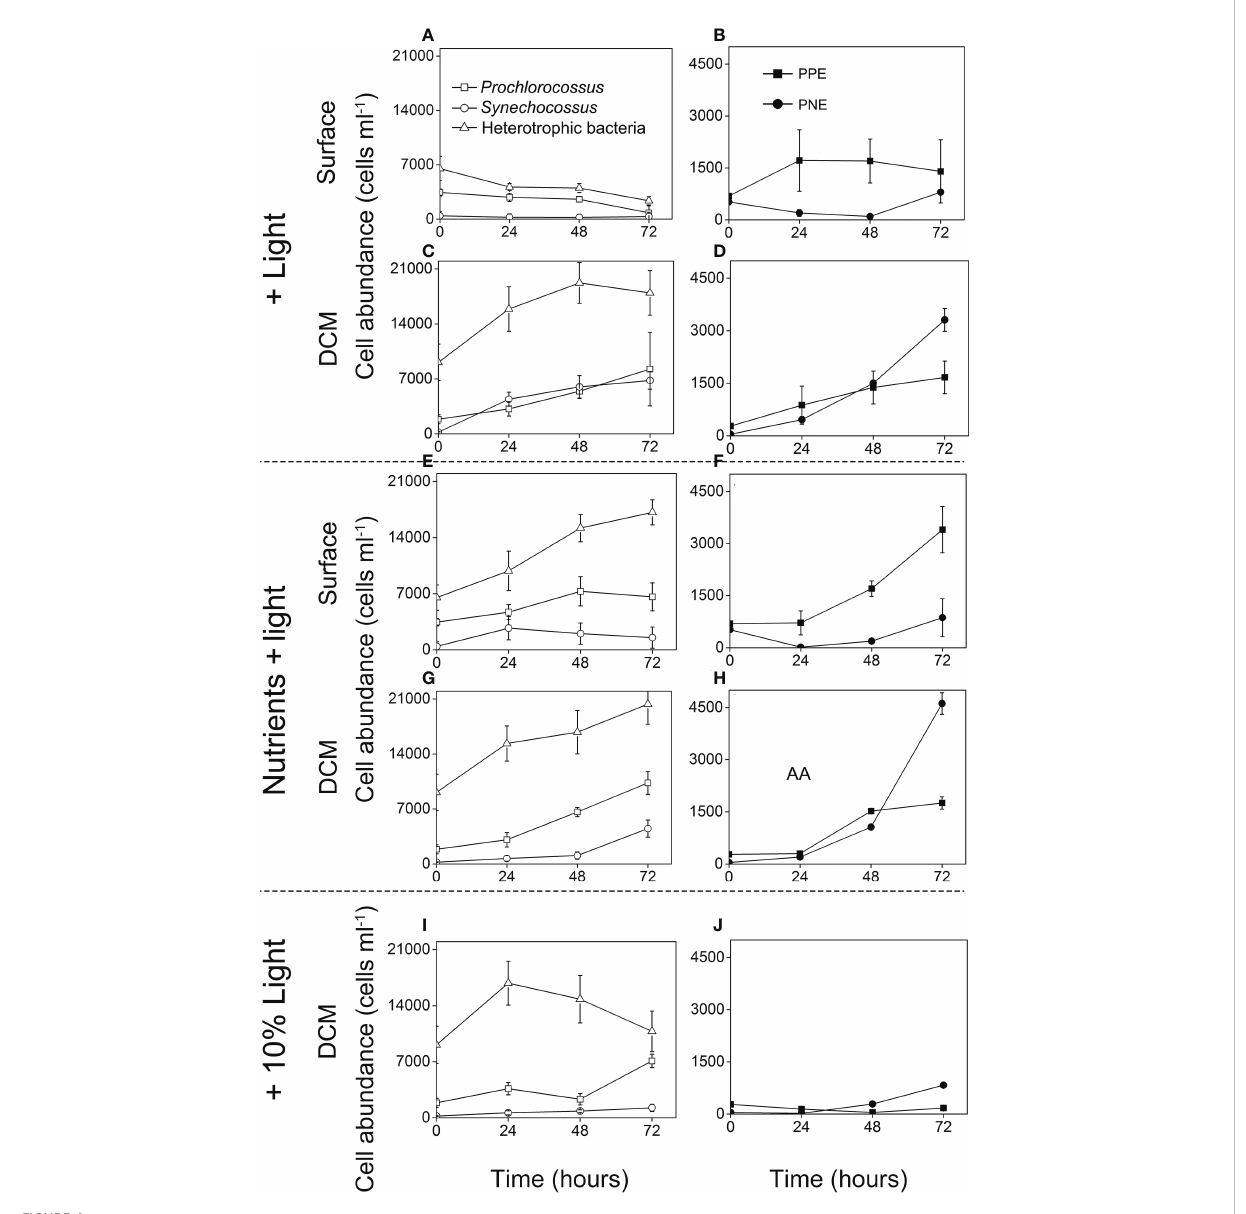
FIGURE 4 Time course of cell abundance of heterotrophic bacteria, Cyanobacteria ( Prochlorococcus and Synechococcus ), PPE (photosynthetic pico- eukaryotes) and PNE (photosynthetic nano-eukaryotes) during the fi eld incubation experiments: the + light groups (A – D) , the + nutrients + light groups (E – H) , the + 10% light group (I – J)